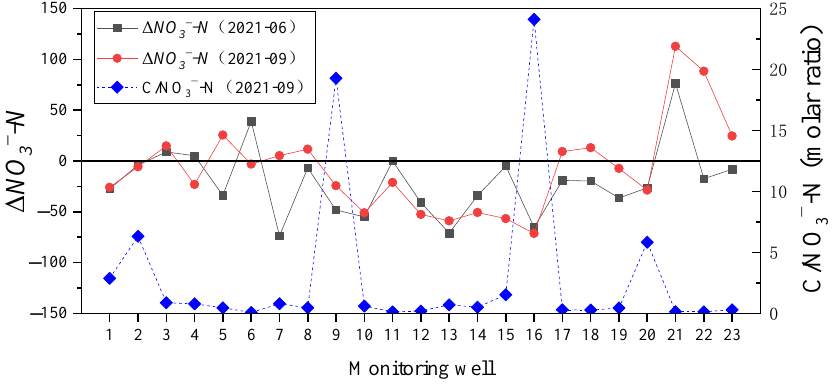
− -N and C/N ratio of ∆ NO 3